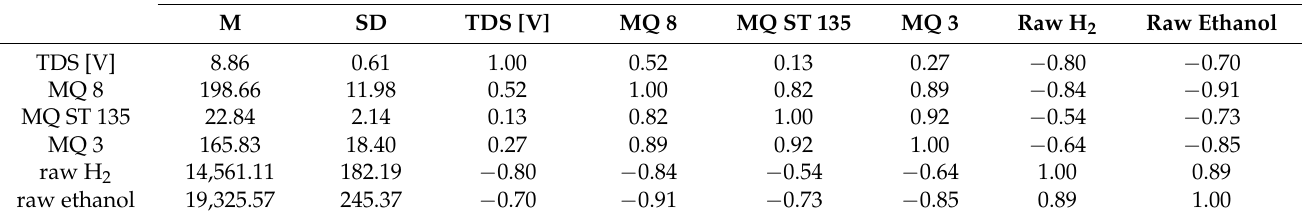
( a ) Comparison of TDS signals and MQ e-nose sensor signals.